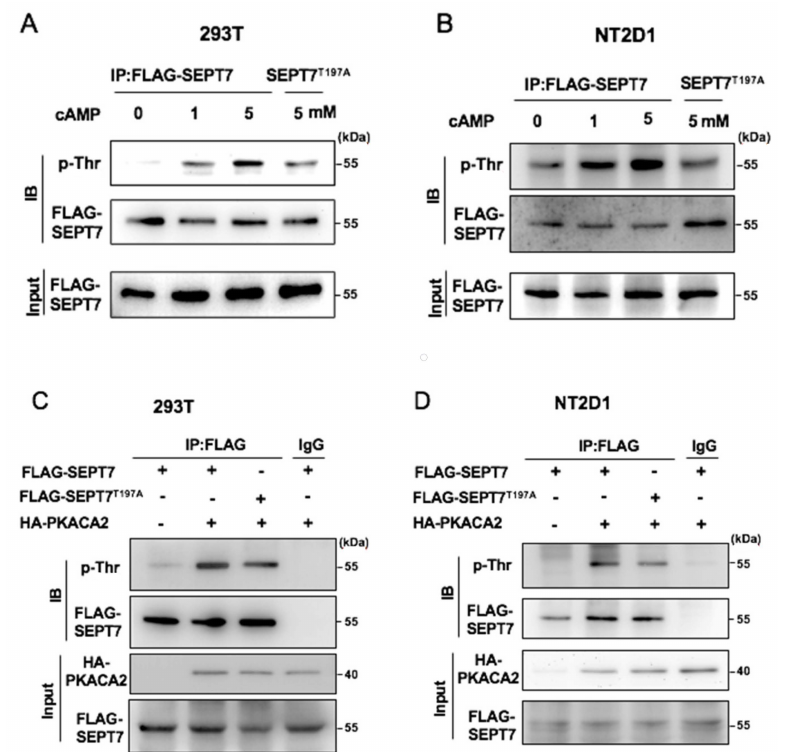
Figure 2. SEPT7 was phosphorylated at the Thr197 site by PKA. Activation of PKA increased SEPT7 phosphorylation at the Thr197 site following treatment with 8-Br-cAMP in a dose-dependent manner, but was reduced in a phosphodeficient SEPT7 (T197A) mutant of 293T ( A ) or NT2/D1 ( B ) cells. ( A ) FLAG-SEPT7 or FLAG-SEPT7 (T197A) was transfected into 293T cells following treatment with 0, 1, or 5 mM 8-Br-cAMP. The levels of the Thr197 phosphorylation were increased in FLAG-SEPT7- transfected 293T cells. Extracts of FLAG-SEPT7-transfected 293T cells or FLAG-SEPT7 (T197A) mutant 293T cells following treatment with 8-Br-cAMP were analyzed by immunoprecipitation (IP) with antibodies against FLAG. ( B ) FLAG-SEPT7 or FLAG-SEPT7 (T197A) mutant was transfected into NT2/D1 cells. The levels of Thr phosphorylation were increased in FLAGSEPT7-transfected NT2/D1 cells, but reduced in FLAG-SEPT7 (T197A) mutant NT2/D1 cells, following treatment with 8-Br-cAMP. Extracts of FLAG-SEPT7 or FLAG-SEPT7 (T197A) mutant-transfected NT2/D1 cells, following treatment with 8-BrcAMP, were analyzed by immunoprecipitation with antibodies against FLAG. PKA phosphorylates SEPT7 on Thr. ( C , D ) FLAG-SEPT7 and FLAG- SEPT7 (197A) mutant, with or without HA-PKACA2, were transfected into 293T cells ( C ) and NT2/D cells ( D ) as indicated, and the expression of phosphorylated threonine, SEPT7, and PKACA2 was detected with antibodies against phospho-threonine, FLAG, and HA. IgG served as a negative